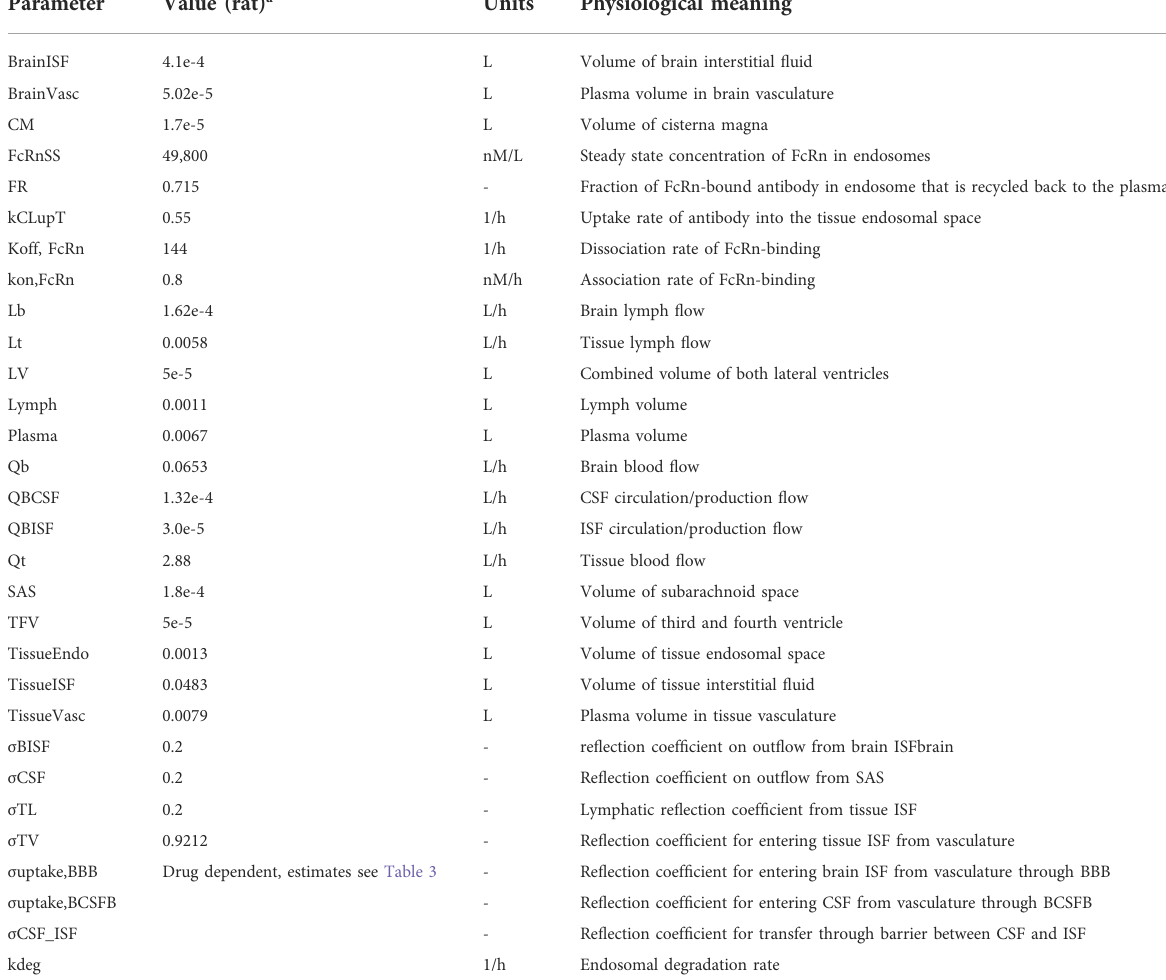
TABLE 1 Model Parameters and their corresponding values, units and physiological